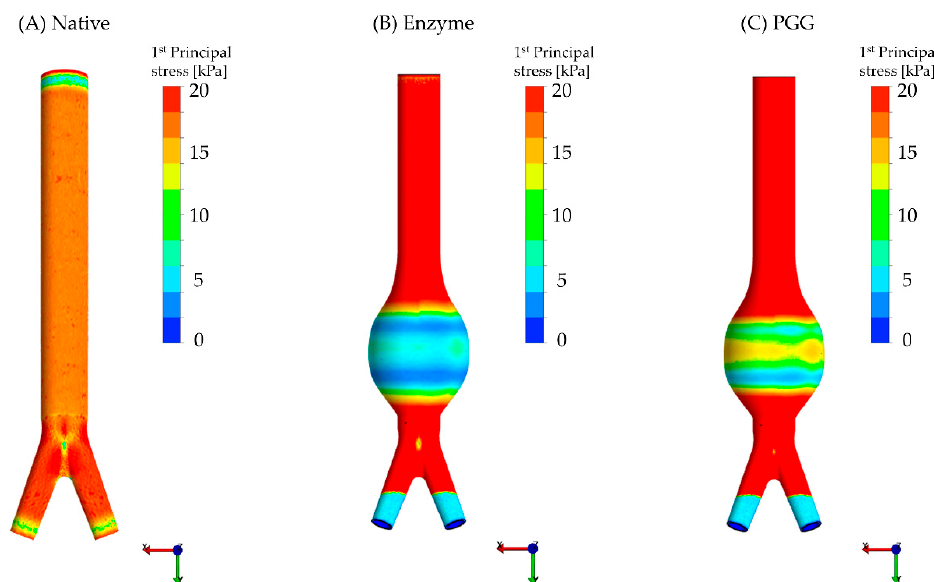
Figure 7. Wall stress spatial distribution for three exemplary FEA models (anterior view): ( A ) Native, ( B ) enzyme and ( C ) PGG treated. The Ogden hyperelastic constitutive material was utilized for the FEA simulations and a 100 mmHg intraluminal pressure was applied to the models. The upper limit of the stress legend was lowered to emphasize the differences across the three groups at the midsection.